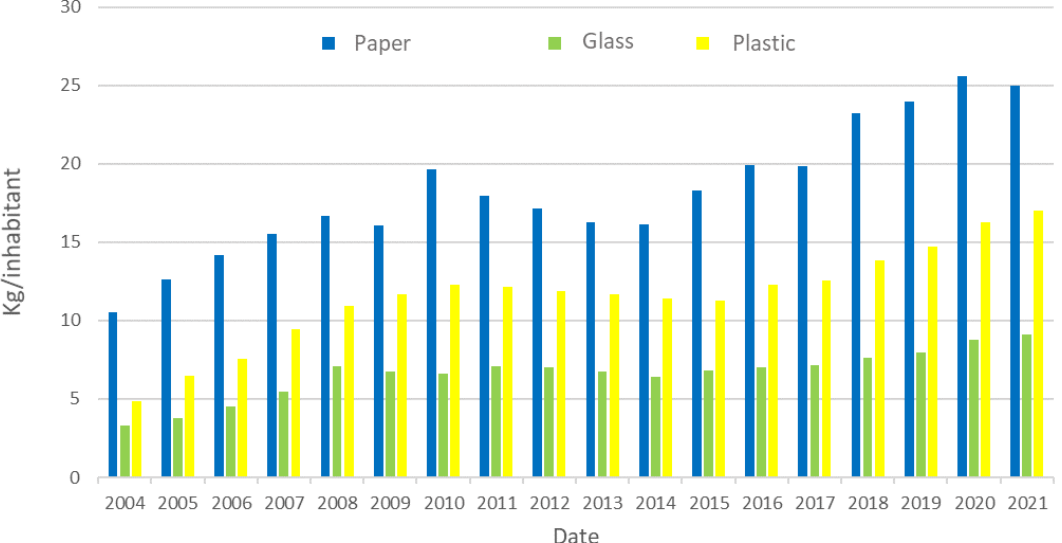
Figure 6. Annual evolution of the selective collection of paper and cardboard, glass and plastic, metal and carbon fractions in the city of Cáceres (kg/inhabitant).